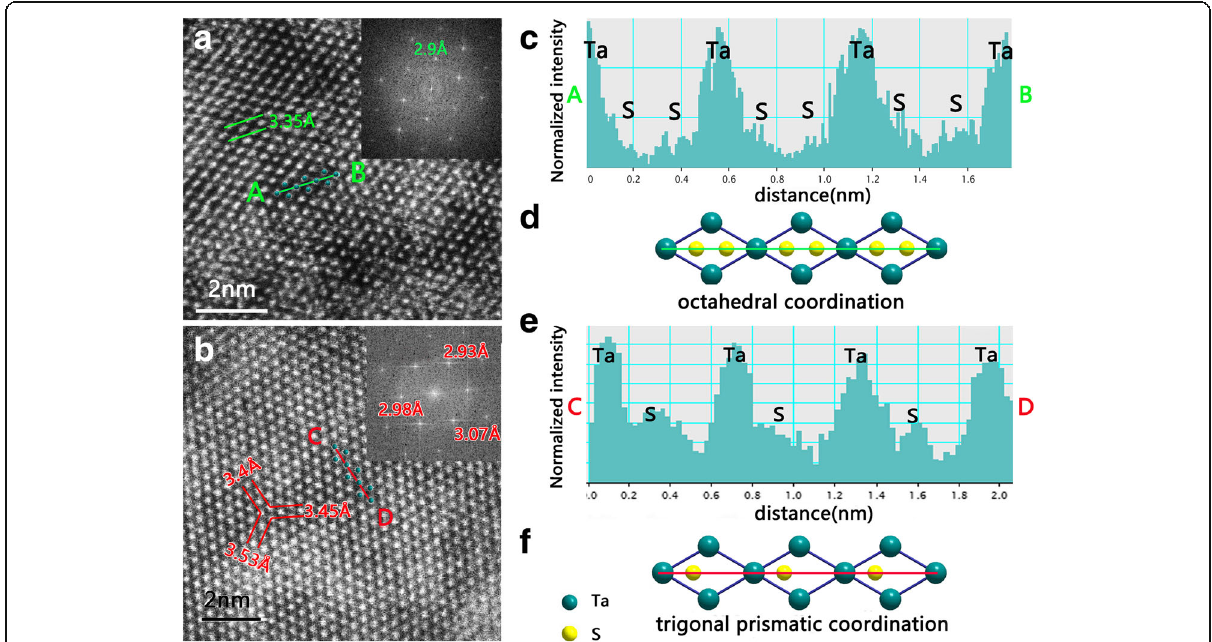
Fig. 6 Atomic structural analysis of monolayer TaS 2 . a Typical HADDF-STEM image of TaS 2 shows clear atomic patterns of octahedral TaS 2 and its FFT pattern. b A typical HADDF-STEM image of TaS 2 shows clear atomic patterns in monolayer triangular TaS 2 and its distorted FFT pattern. c Bottom intensity profiles of 1T-TaS 2 along AB line, and the structural model of octahedral TaS 2 are showed for contrast. d Bottom intensity profiles along CD line exhibit the location of Ta and S atoms which indicate atomic position of the trigonal prismatic and the structural model of trigonal TaS